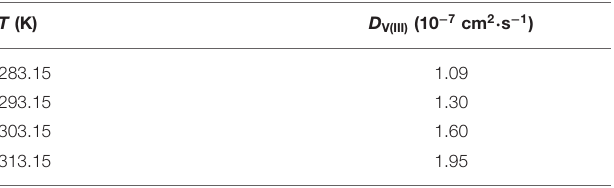
TABLE 5 | Diffusion coefficients of V(III) ions calculated from Figure 10 at different temperatures. T